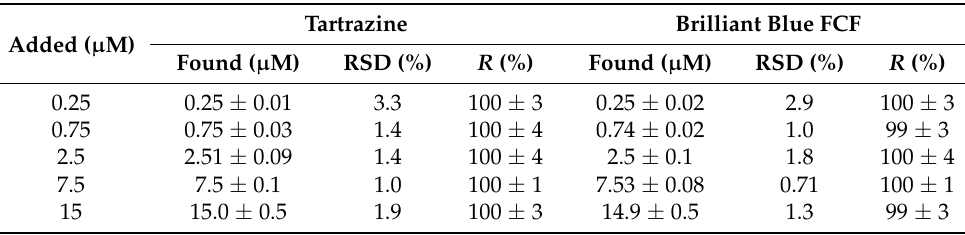
Table 5. Simultaneous quantification of tartrazine and brilliant blue FCF in model mixtures using MnO 2 nanorods-based sensor in phosphate buffer pH 7.0 ( n = 5; p = 0.95). Added ( µ M)